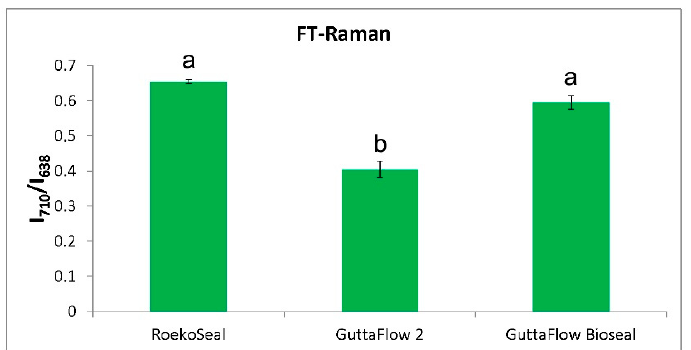
Figure 6. I 710 /I 638 intensity ratio (average ± standard deviation) as calculated from the FT ‐ Raman spectra of fresh commercial sealers under study. Different letters represent statistically significant differences ( p < 0.05) between values.